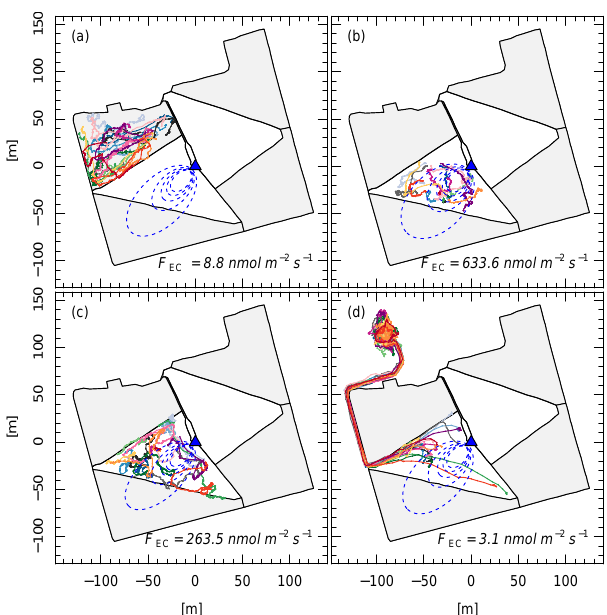
Figure 5. Four examples of 30min intervals with similar wind and footprint conditions (blue isolines) but different cow distribution and observed fluxes ( F EC ). For each cow, the registered GPS po- sition (5s resolution over 30min) is marked with a line of a differ- ent color. Paddocks representing near cows cases are white and far cows are gray. (a) No cows in the footprint, i.e. soil fluxes are mea- sured, (b–d) the higher the number and residence time of cows in the footprint the larger the observed flux.